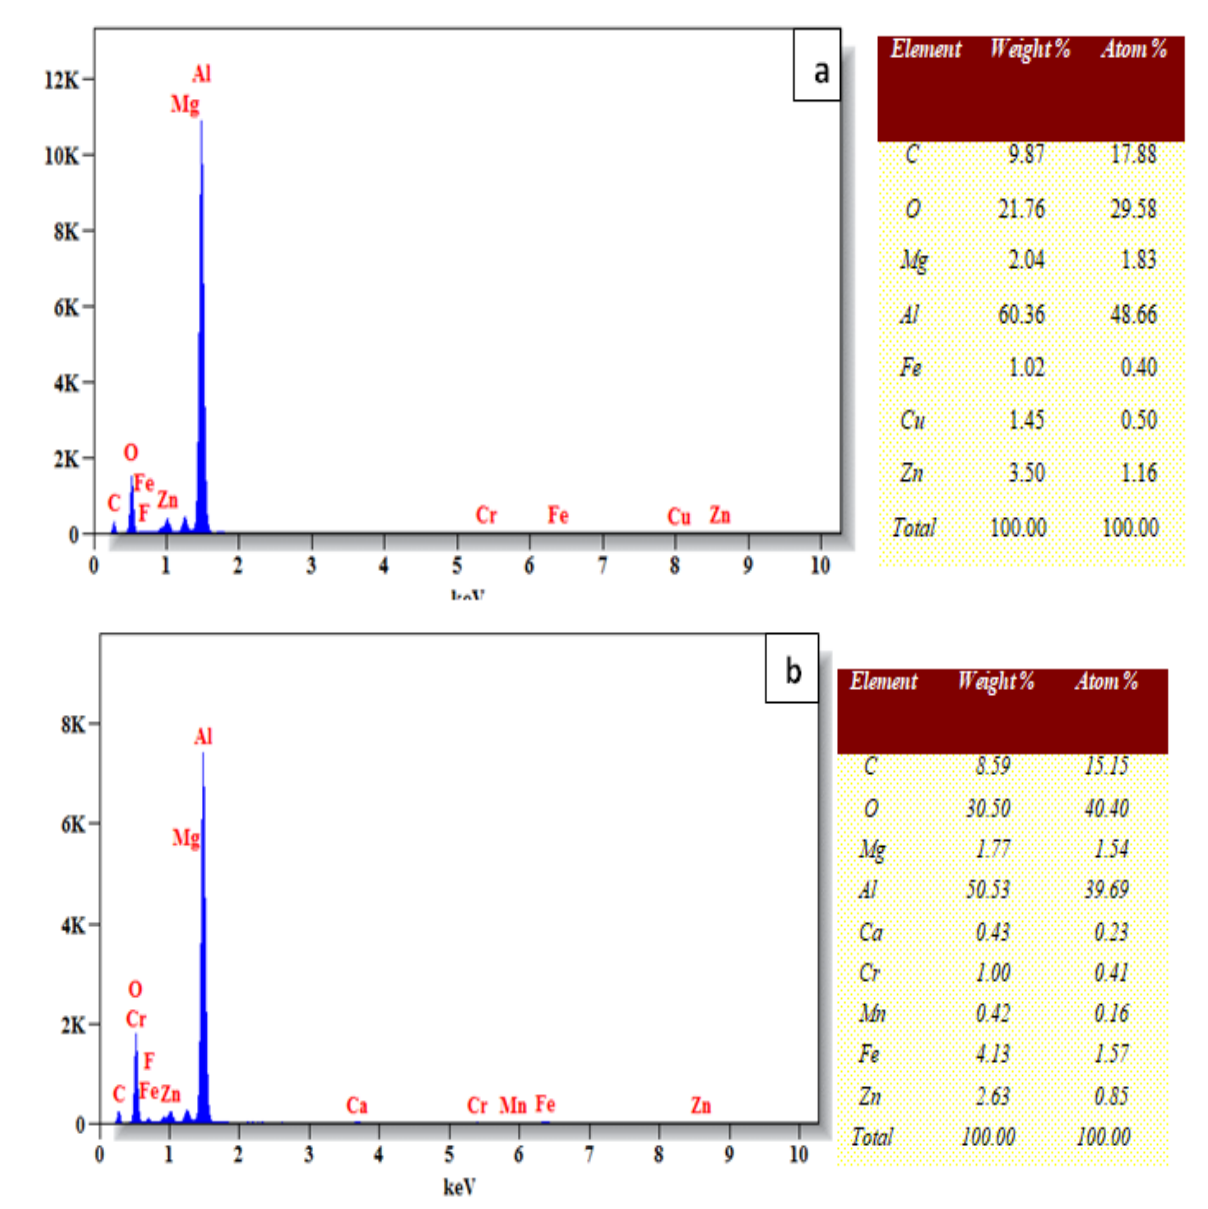
Figure 11. ( a ) EDS Image of composite worn surface aged at 250 °C of 30 N load at 2000 m sliding distance. ( b ) EDS Image of non-aged composite worn surface of 30 N load at 2000 m sliding distance.